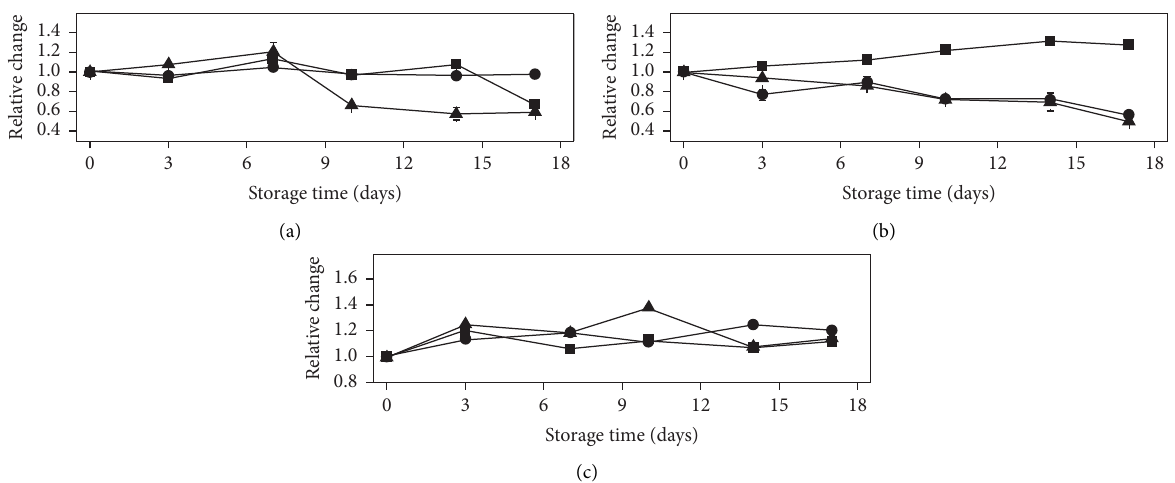
Figure 2: Changes in total phenols (a), ascorbate levels (b), and antioxidant capacity (c) of eggplant fruit during cold storage (control fruit ( ■ ); beeswax-coated fruit ( ● ); citrate-treated-beeswax-coated-fruit ( ▲ )).